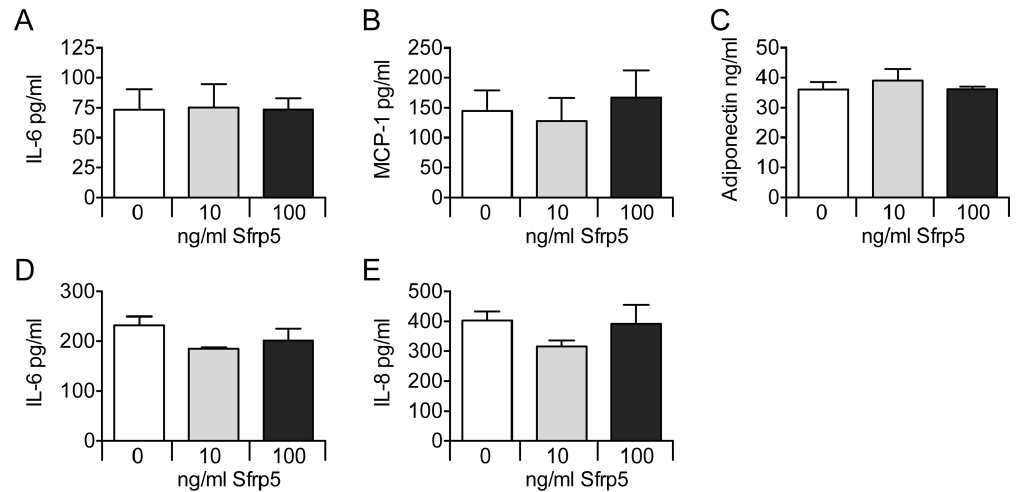
Figure 1. Effect of Sfrp5 on adipokine and myokine release (unstimulated conditions). Primary human adipocytes (A–C) and primary human skeletal muscle cells (D–E) were exposed to increasing amounts of Sfrp5 for 24 h. Cytokine release by the adipocytes and myotubes was quantified by ELISA, and expressed as mean 6 standard error of the mean (A–C: n=5; D–E: n=4).